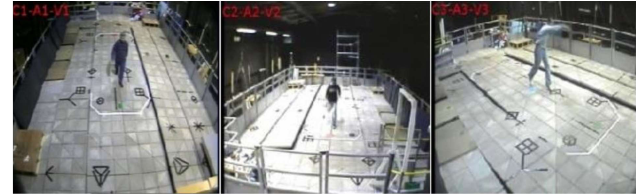
Figure 21. Samples from MuHAVI dataset